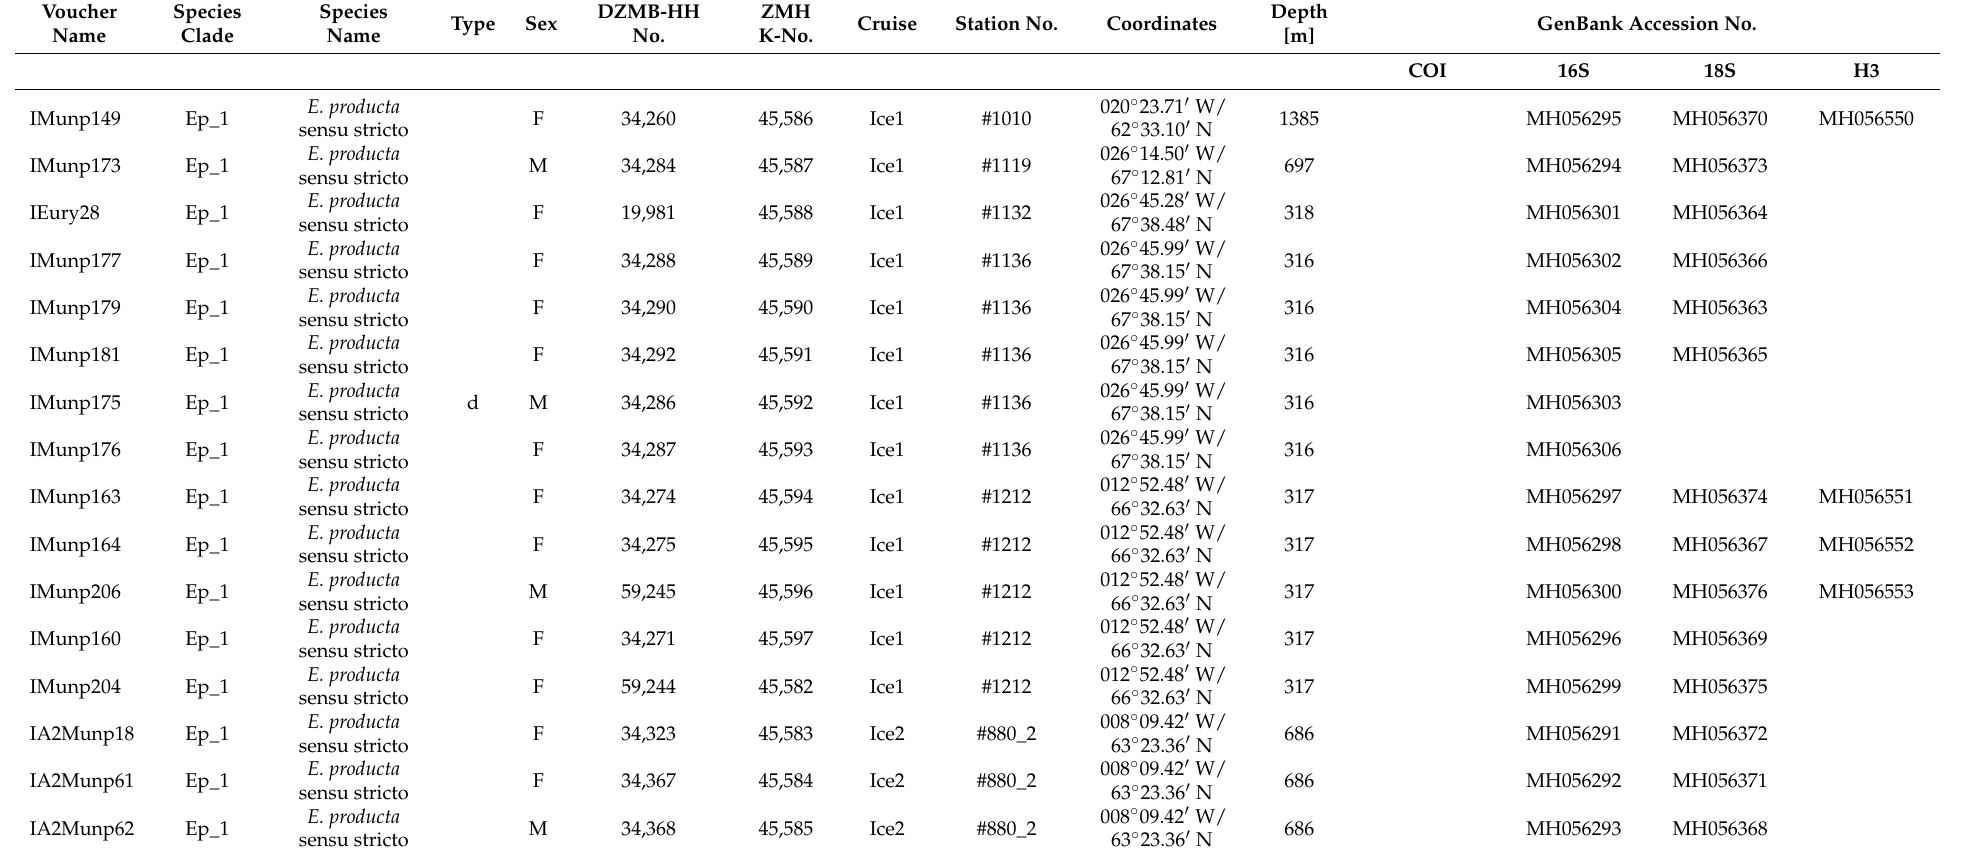
Table 1. Voucher specimen information with reference to voucher name; clade names of Schnurr et al. [28]; species names; type status (H, holotype; P, paratype; d, dissected), sex (F, female; M, male; J, juvenile), German Centre for Marine Biodiversity Research numbers (DZMB HH), Zoological Museum of Hamburg collection numbers (ZMH K), cruise name (Ice1, IceAGE1 cruise; Ice2, IceAGE2 cruise), station number, sampling coordinates, sampling depth, and GenBank Accession numbers of COI, 16S, 18S, and H3. The table was reprinted and adapted from [28] by permission from Springer Nature, Marine Biodiversity